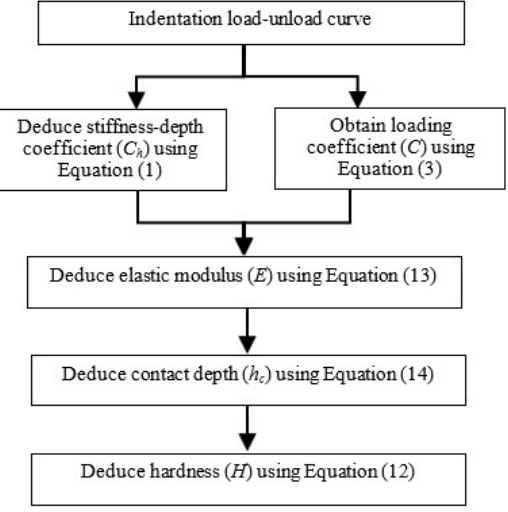
Figure 6. Sti ff ness-based reverse algorithm. Figure 6. Stiffness ‐ based reverse algorithm.